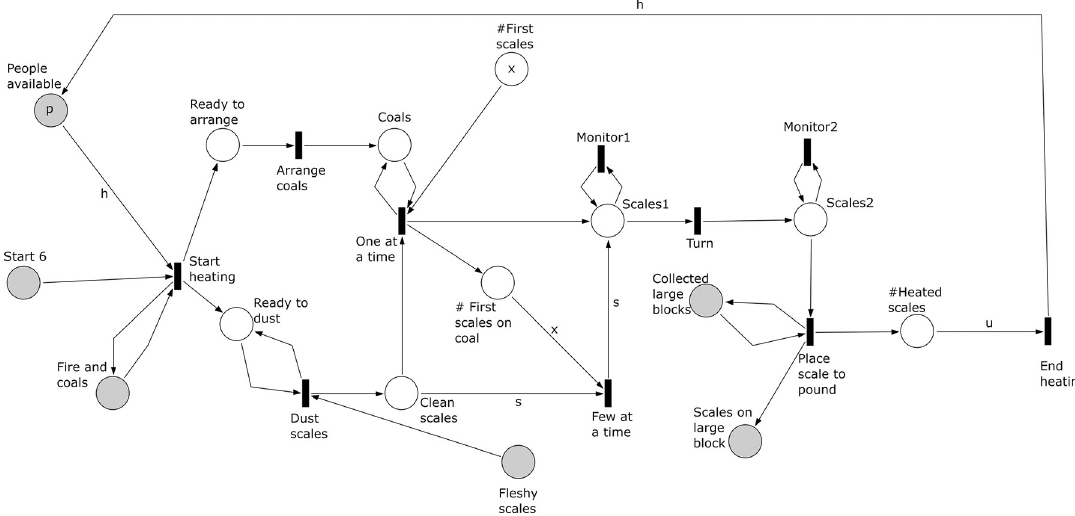
Fig 8. Subprocess 6 Heat Selected Scales of the A . coranica